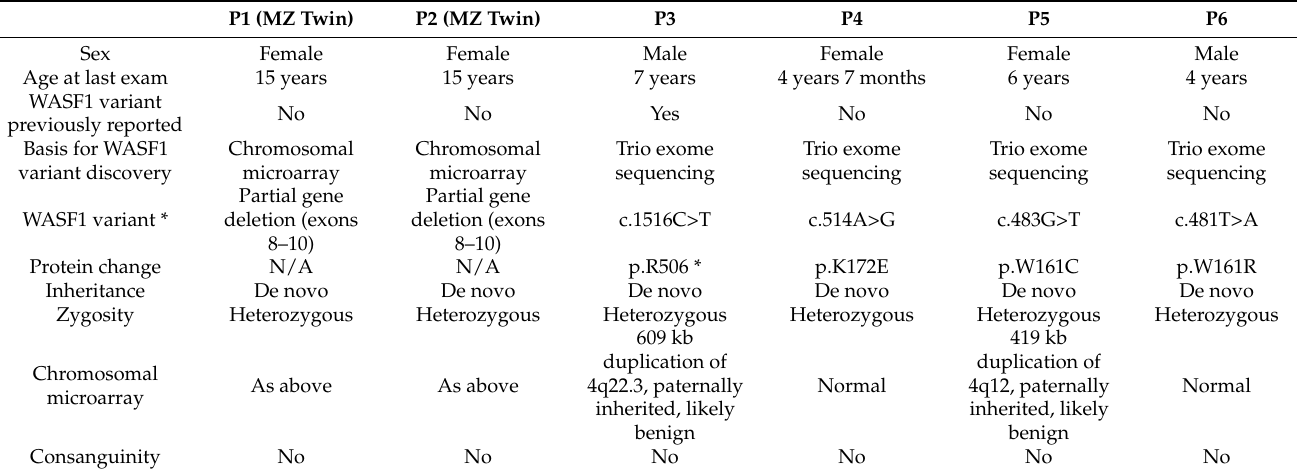
Table 1. Demographic and genetic features of the cohort.